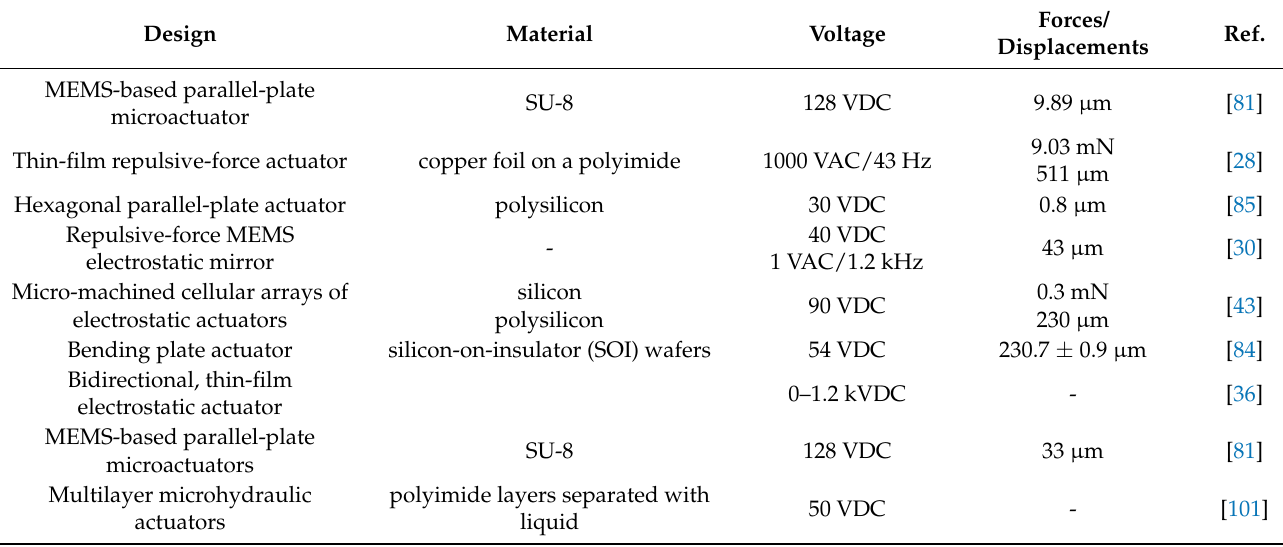
Table 6. Electrostatic actuators reported in the last 6 years.